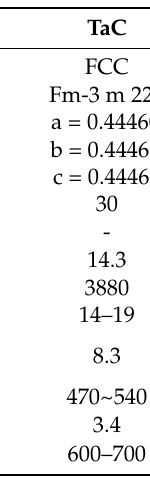
Figure 1. Comparison of the melting points of metals for ultra-high temperature ceramics. Table 1. Some properties of carbide